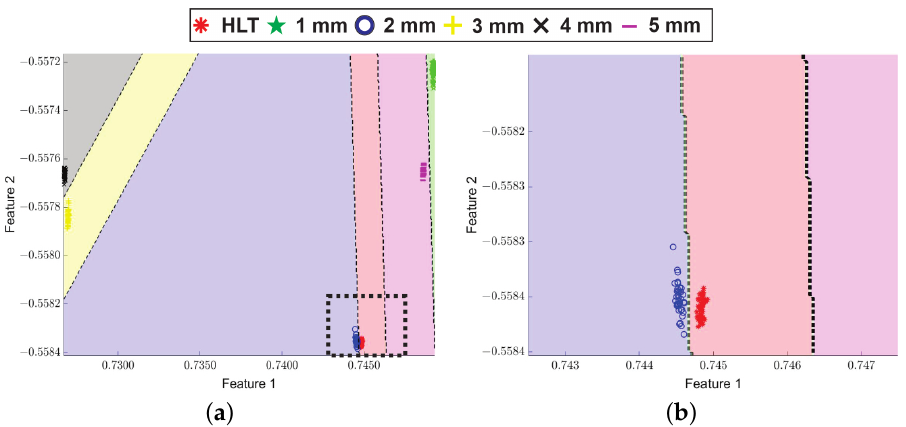
Figure 13. Projection of the decision regions for the multiple fault classification computed by the proposed FFNN-based classifier when the induction motor is driven at 15 Hz by using a VFD: ( a ) Complete view of the projection. ( b ) Zoomed view of the black rectangle zone.